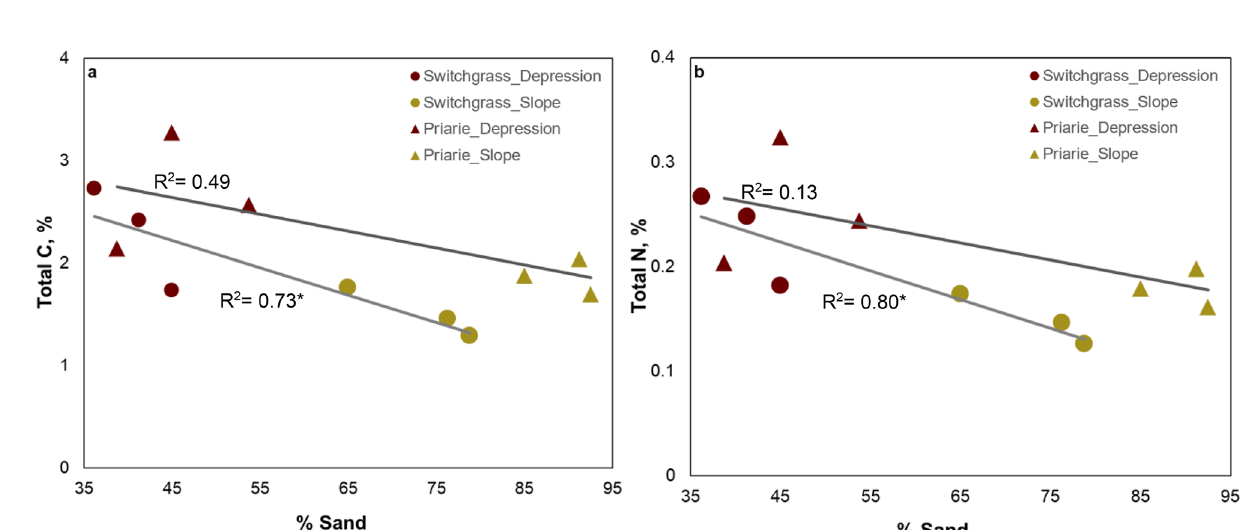
Pore characteristics prior to plant growth experiment. In both plant systems topography signifi- cantly affected only the solid-pore interfacial area values, which were higher in soils from slope than in soils from depression (Table 2 and Table S3). Pore connectivity was significantly higher in soil from depressions than in slopes, but only in prairie system. Neither total nor image-based (pores > 18.2 μm) porosity was affected by topography in both plant systems. Pore size distributions differed between the two topographies and the abun-